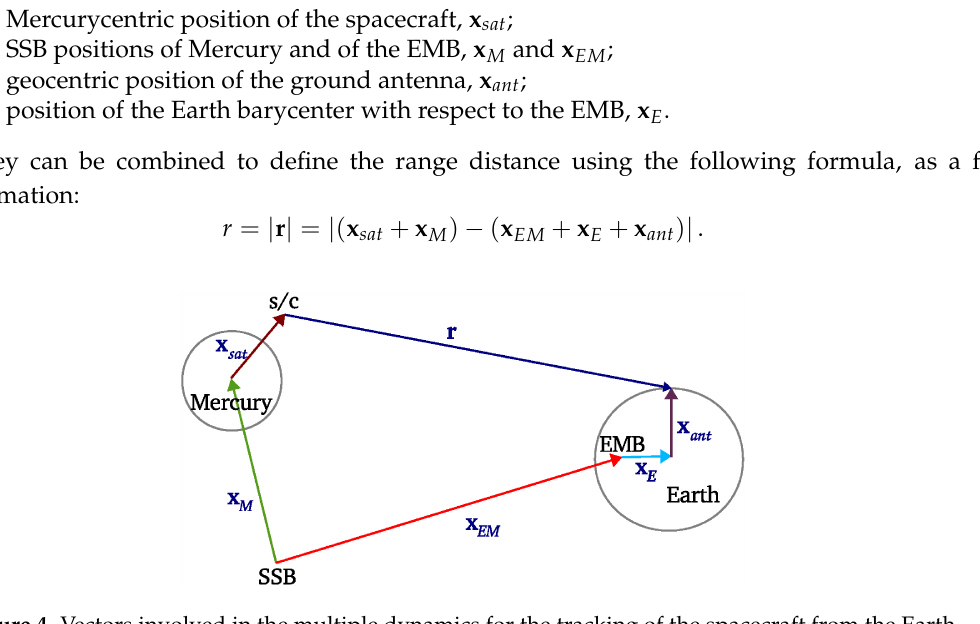
Figure 4. Vectors involved in the multiple dynamics for the tracking of the spacecraft from the